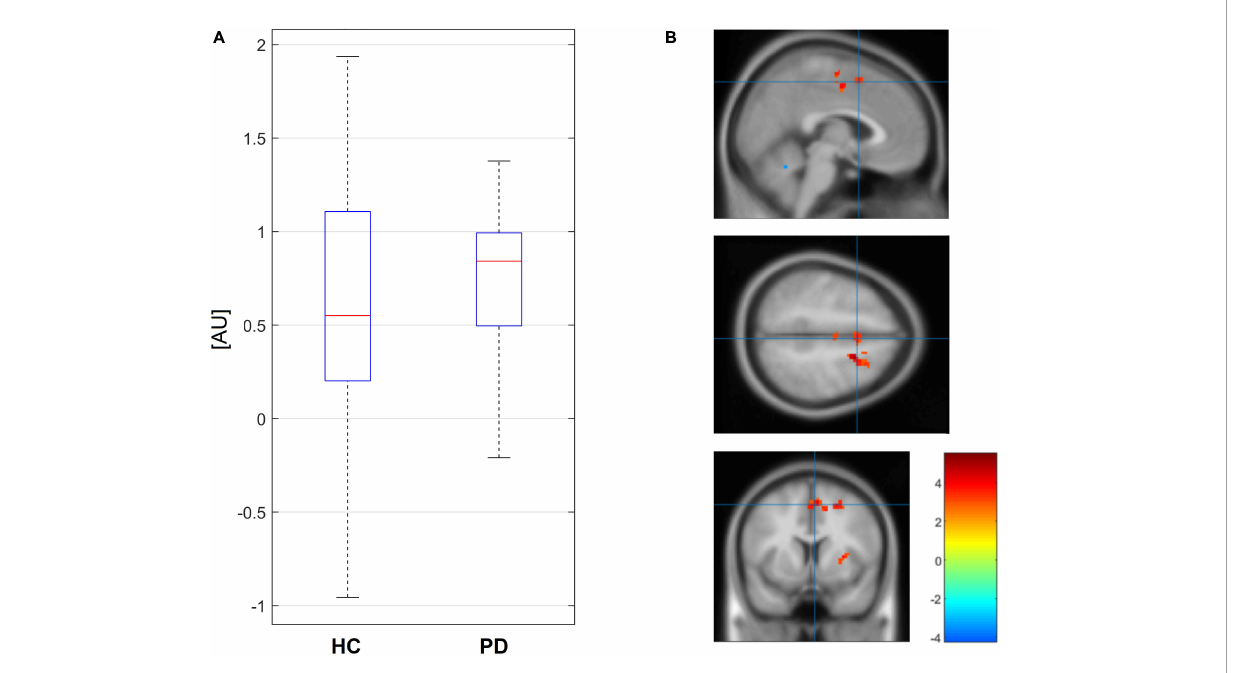
FIGURE2 Boxplots of values of seed PPI connectivity in contrast for non-canonical stimuli from right striatum to SMA (3.73, 8.37, and 52.5) are depicted on the left (A) . Localization of the position in parametric map of the two sample t-test between PD and HC (three orthogonal views) with initial cutoff p = 0.005 for cluster level inference is on the right (B) .